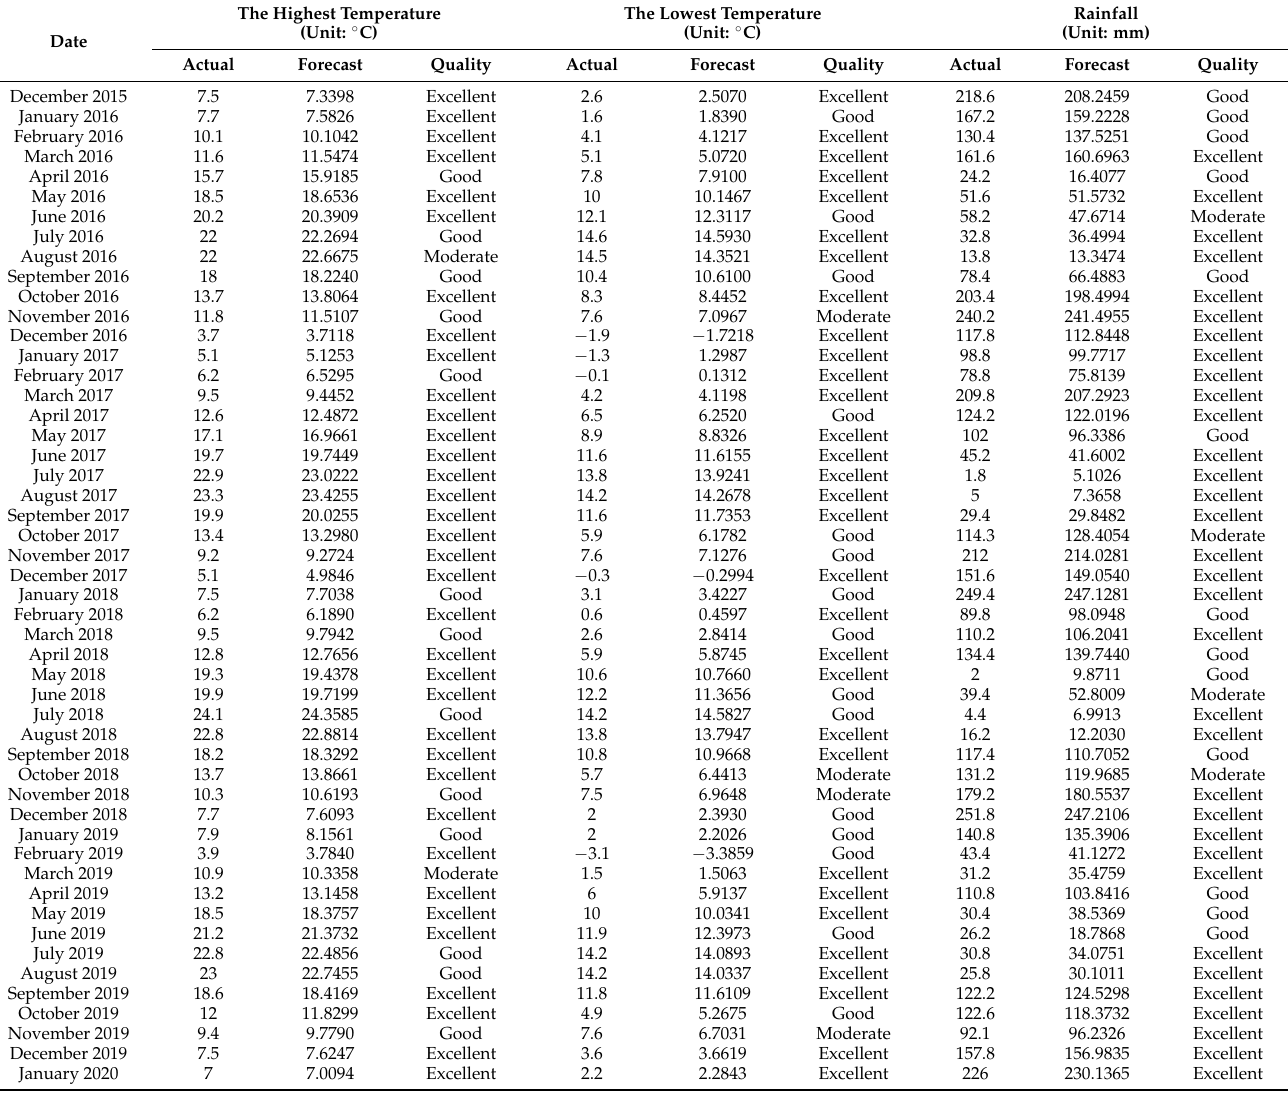
Table 5. Predicting performance for SOPDEL model under the evaluation system made in this study.